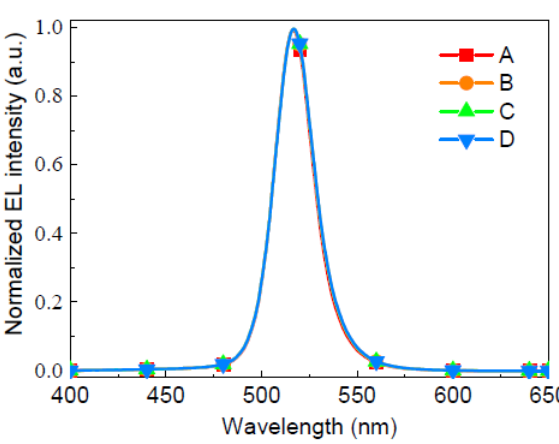
Figure 5. Normalized EL spectra of the devices.